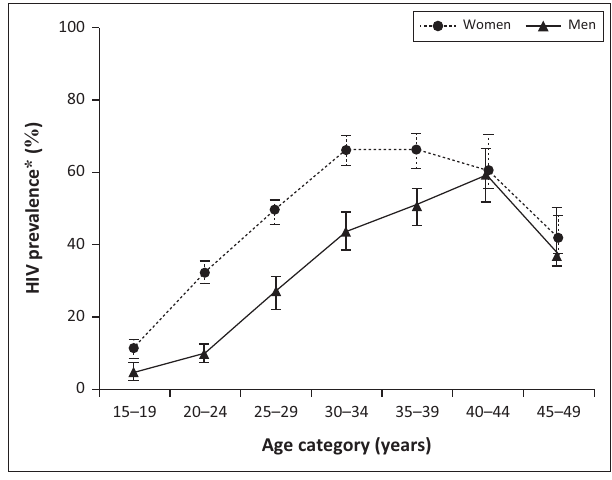
FIGURE 3: The HIV prevalence rates in a KwaZulu-Natal community in South Africa by age and